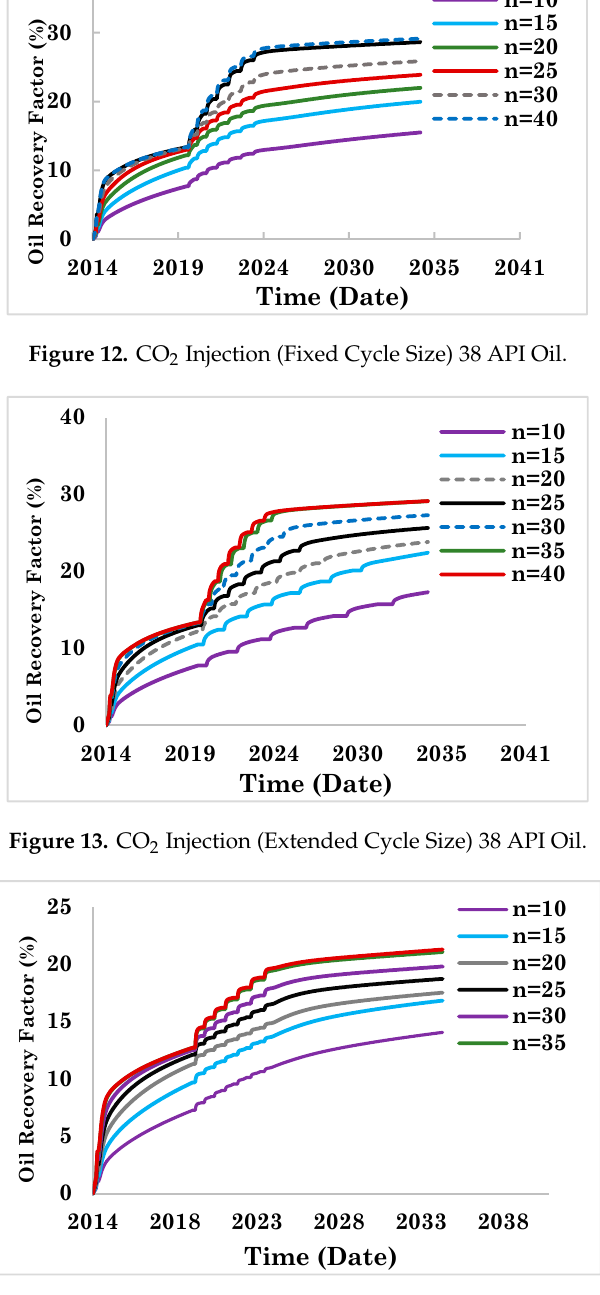
Figure 14. NG Injection (Fixed Cycle Size) 38 API Oil.